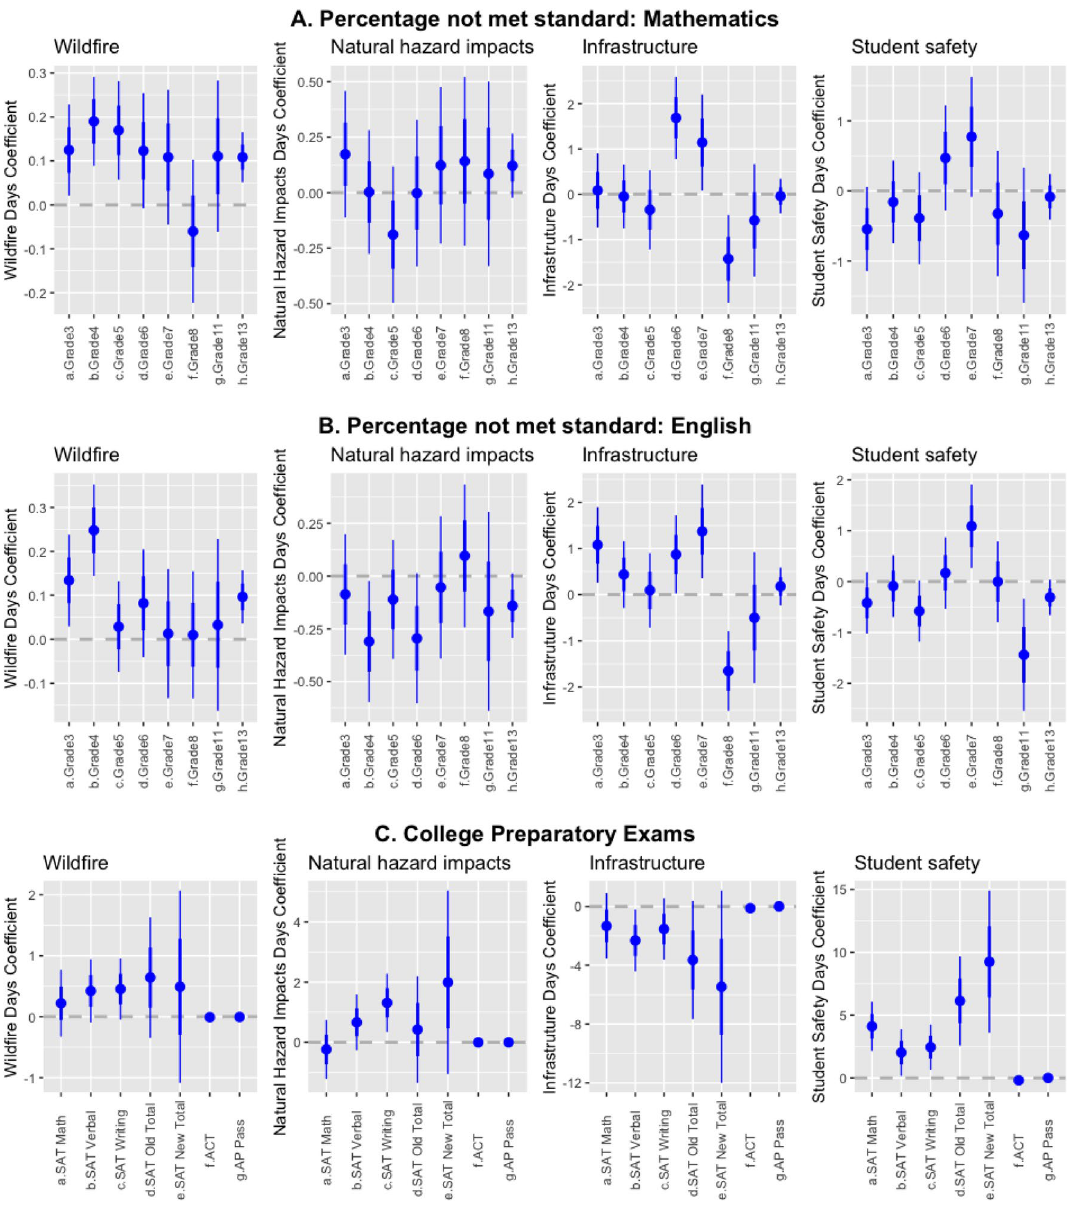
Figure 2. Effect of school closures on standardized test scores by closure cause for ( A ) grades 3–11 and all grades (grade 13) for mathematics, ( B ) grades 3–11 and all grades (grade 13) for English, and ( C ) college standardized exams. Lines indicate confidence intervals two standard deviations from the mean. Note that the y-axis scale varies among